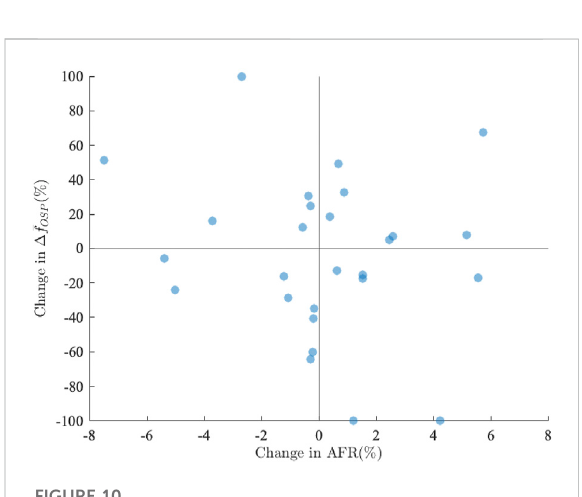
FIGURE 10 Relative change between Δ f OSPB and Δ f OSPD plotted versus relative change between AFR B and AFR D